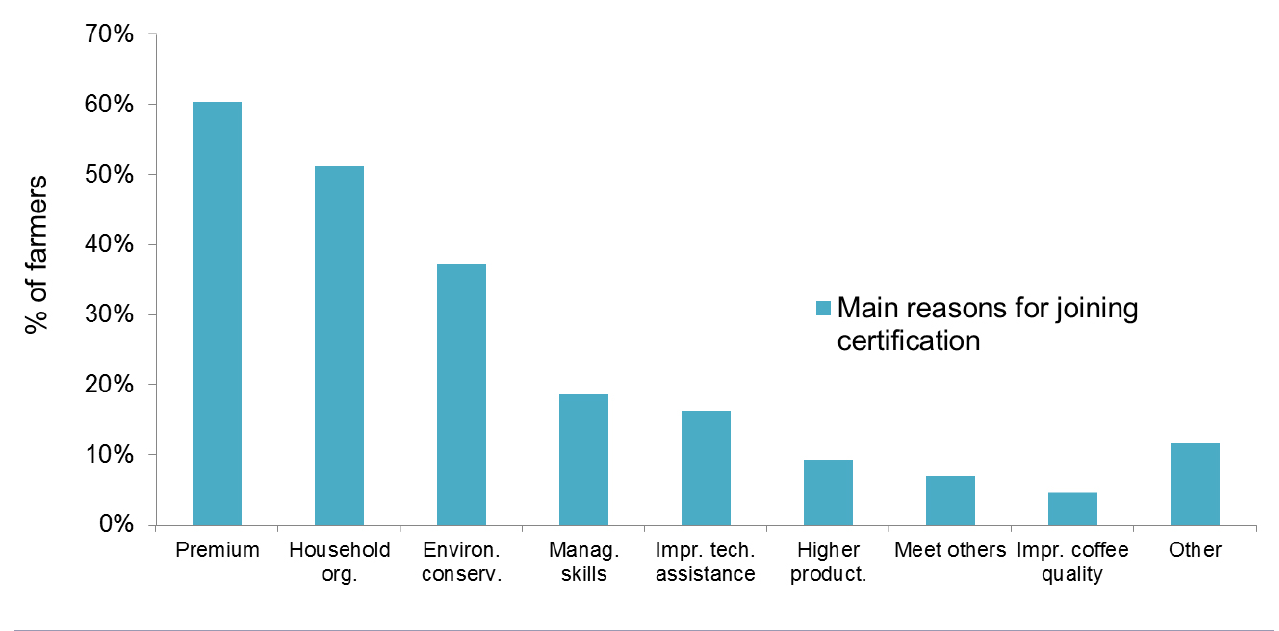
Fig. 3 . Certified farmers' main reasons for joining certification (n =